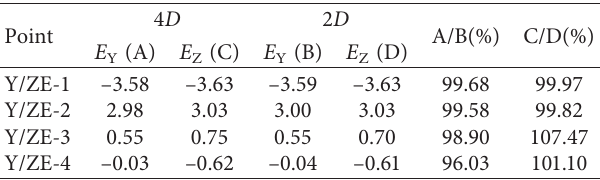
Table 6: Displacement of measuring points of secondary lining (mm).